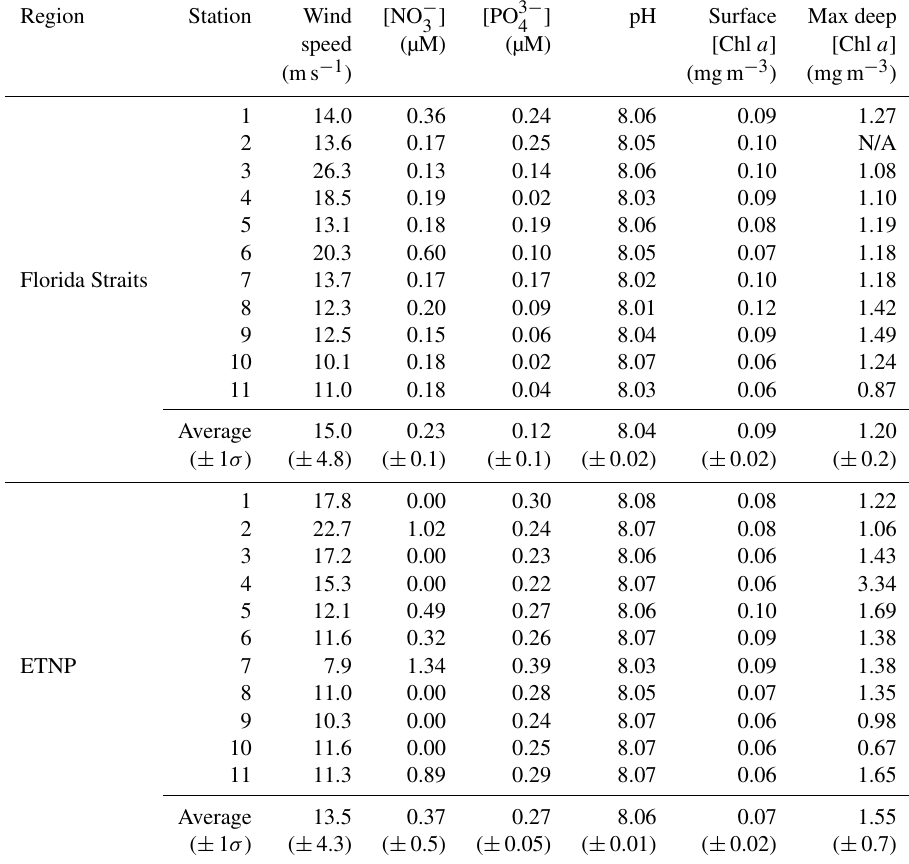
Table 1. Seawater sampling station characteristics.